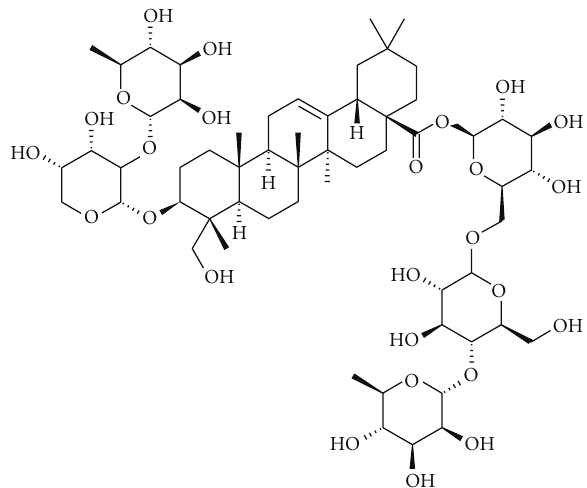
Figure 1: Chemical structure of hederacoside C (3-[[2-O-( α -L- Rhamnopyranosyl)- α -L-arabinopyranosyl]oxy]-23-hydroxyolean- 12-en-28-oic acid 6-O-[4-O-( α -L-rhamnopyranosyl)- β -D- glucopyranosyl]- β -D-glucopyranosyl